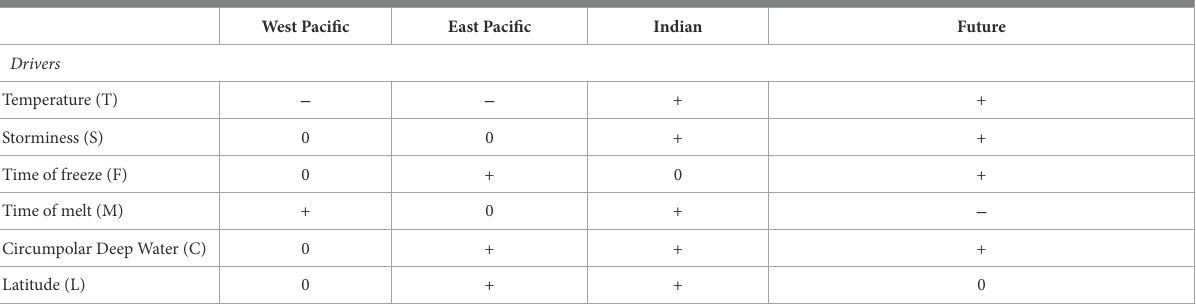
(b) Summary of qualitative differences between drivers in MEASO sectors relative to the Atlantic Sector (based on Morley et al., 2020; Central and East Indian Sectors are